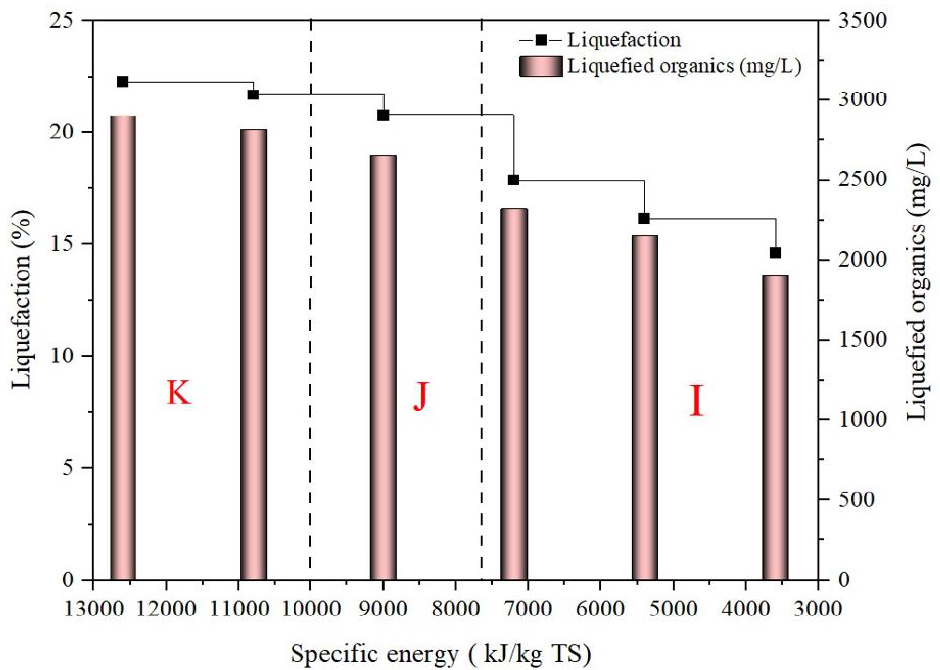
Figure 2. Impact of SL specific energy on LOR and liquefaction efficiency.